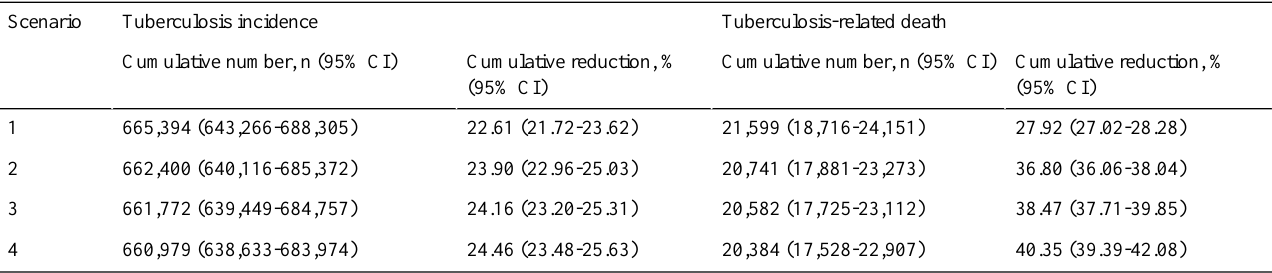
Table 4. Impacts of different intervention scenarios on pulmonary tuberculosis (PTB) epidemiology in Henan province, China, from 2015 to 2025.